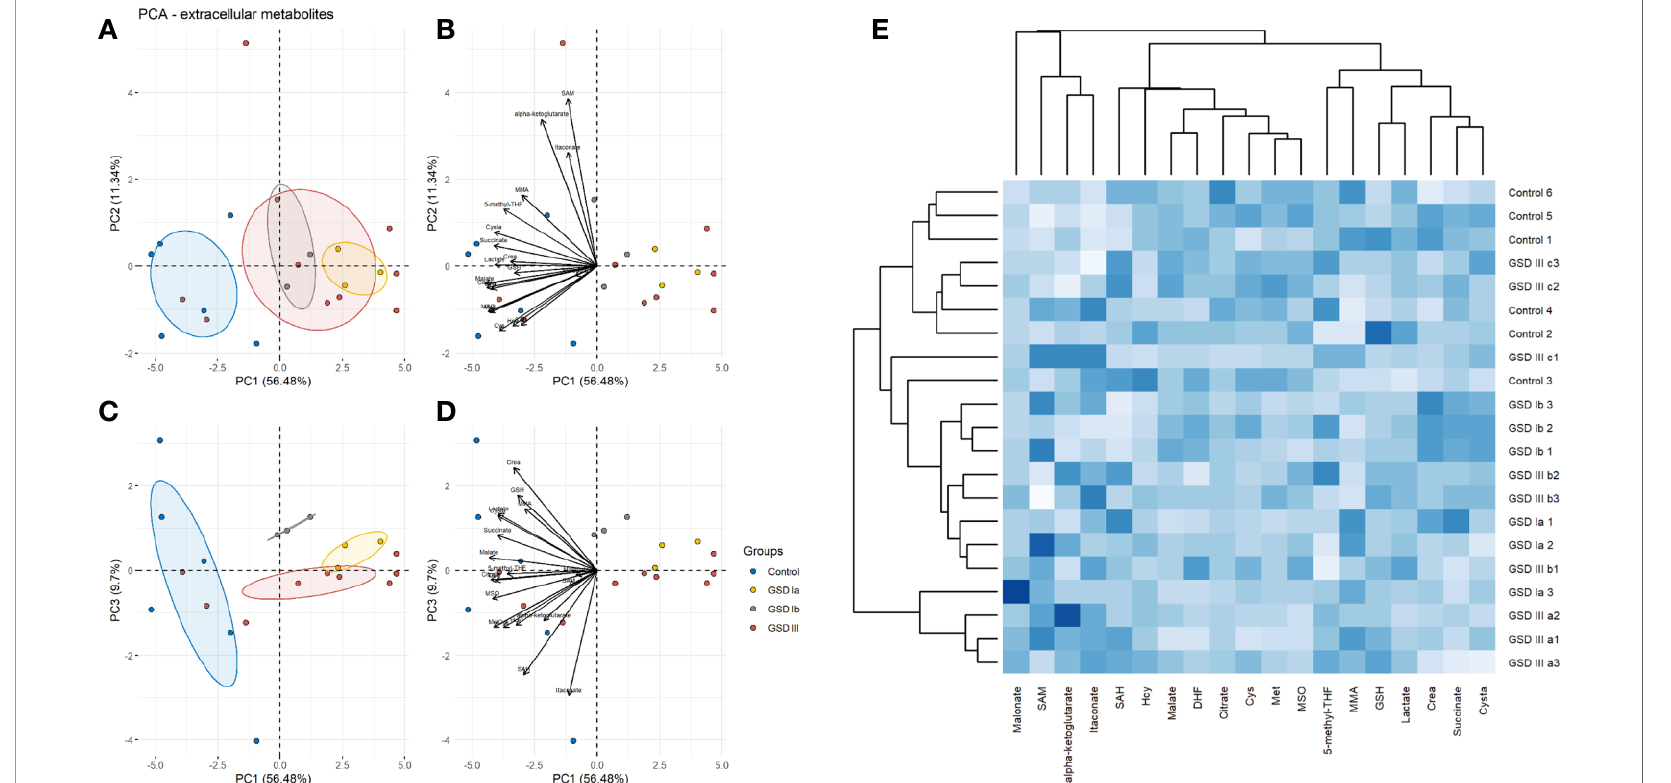
FIGURE 3 | Principal component analysis (PCA) of extracellular metabolites. Panel (A) Score plots of PC1-PC2. Panel (B) Loading plots of PC1-PC2. Panel (C) Score plots of PC1-PC3. Panel (D) Loading plots of PC1- PC3. Control: n=3; GSDIa n =1; GSDIb n=1; GSDIII n=3, each by triplicate. A total of 19 metabolites were included in the analysis. Ellipses shown at 95% con fi dence centered around the mean of data points. The small overlap among ellipses depicts differences between healthy controls and disease subtypes. Panel (E) Heatmap of extracellular metabolites with hierarchical clustering (Euclidean distance, complete